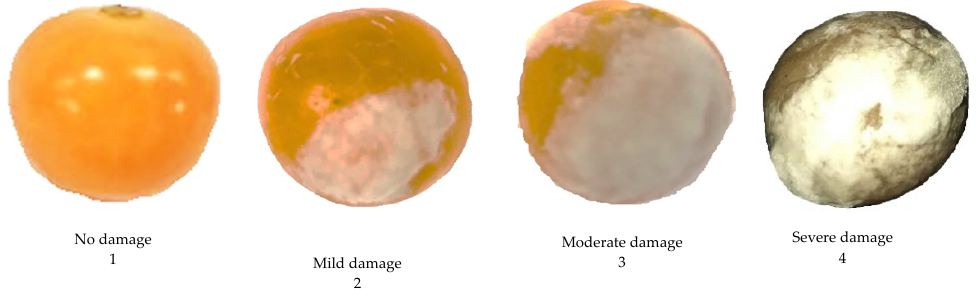
Figure 1. The damage scale of the cape gooseberries.